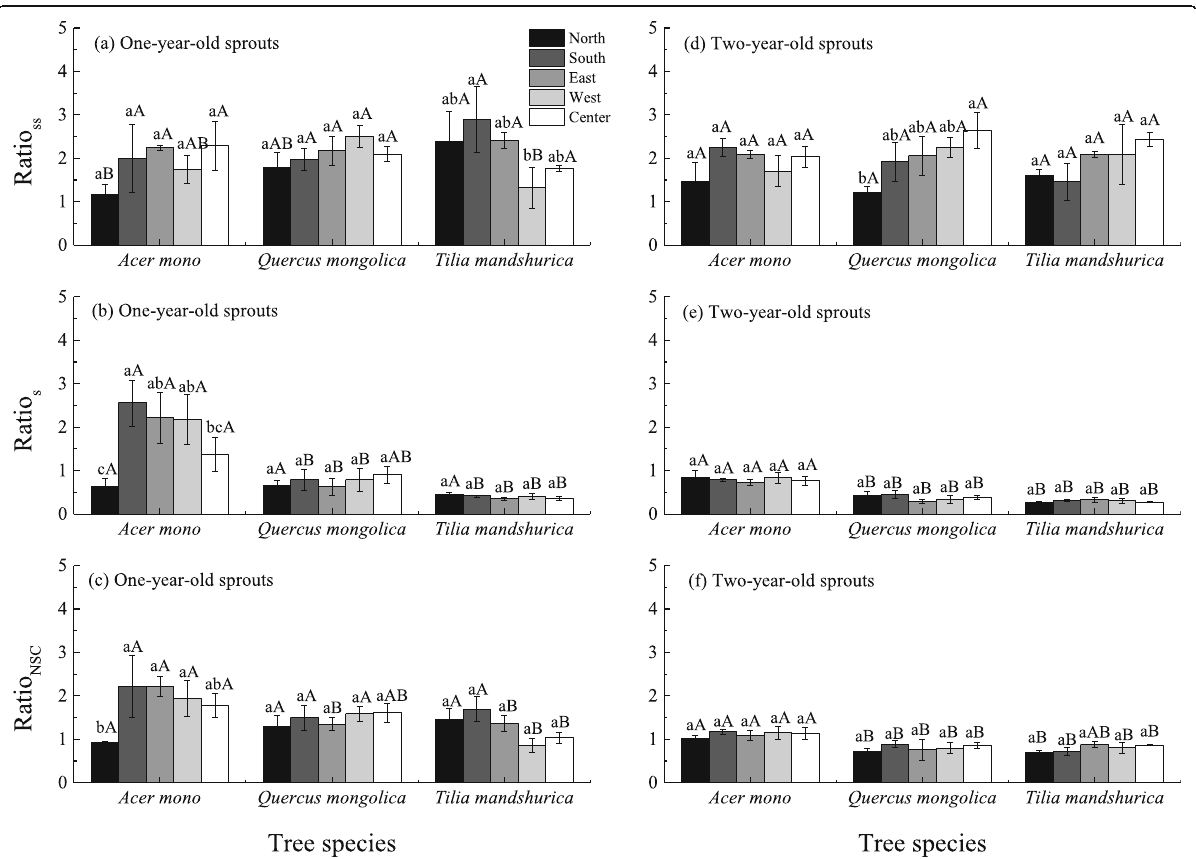
Fig. 6 Ratio of leaf NSCs concentrations to stem NSCs concentrations in 1-year-old and 2-year-old sprouts at different within-gap positions for three tree species. The data are presented as the mean ± S.D. Different capital letters indicate significant differences ( P < 0.05) among tree species. Different lowercase letters indicate significant differences ( P < 0.05) among within-gap positions. Ratio ss , Ratio S , and Ratio NSC : the ratio of leaf to stem for soluble sugar, starch, and NSC concentrations,